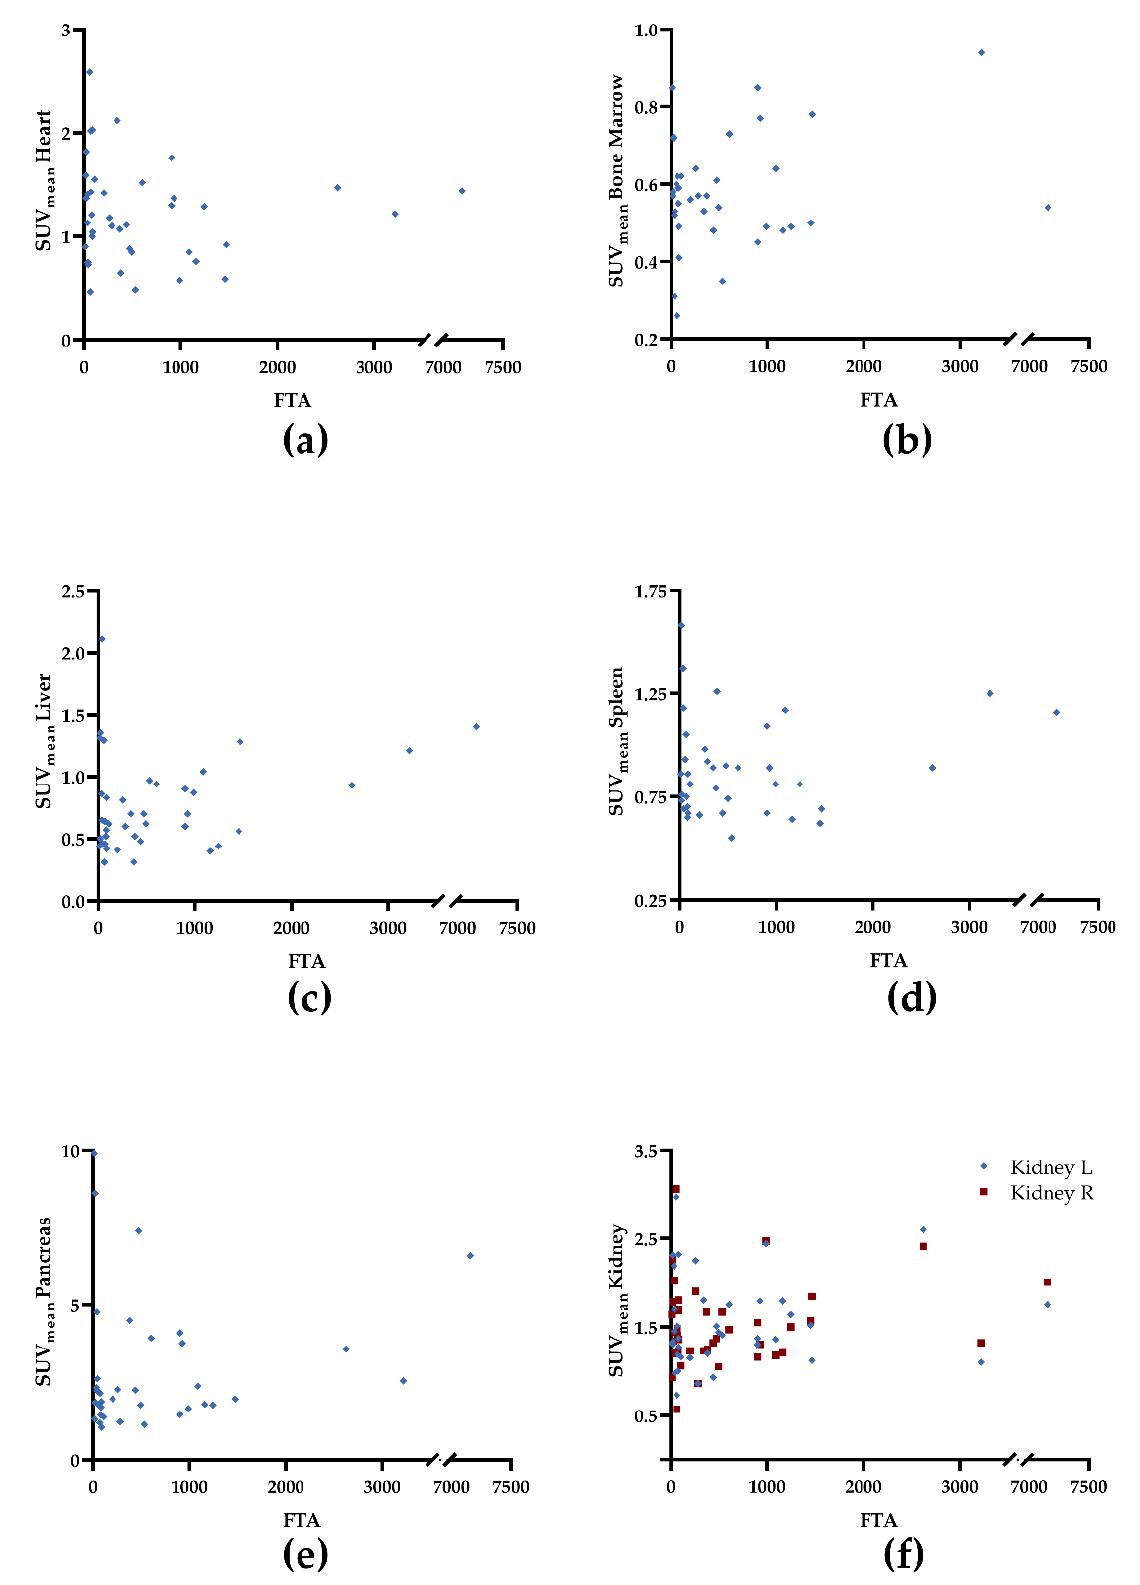
Figure 3. Correlative plots of fractional tumor activity (FTA) and mean standardized uptake values (SUV mean ) from organs: ( a ) heart; ( b ) bone marrow, ( c ) liver, ( d ) spleen, ( e ) pancreas, and ( f ) kidney. Rhombuses and squares are partially overlaid. No significance was reached. R = right. L = left.